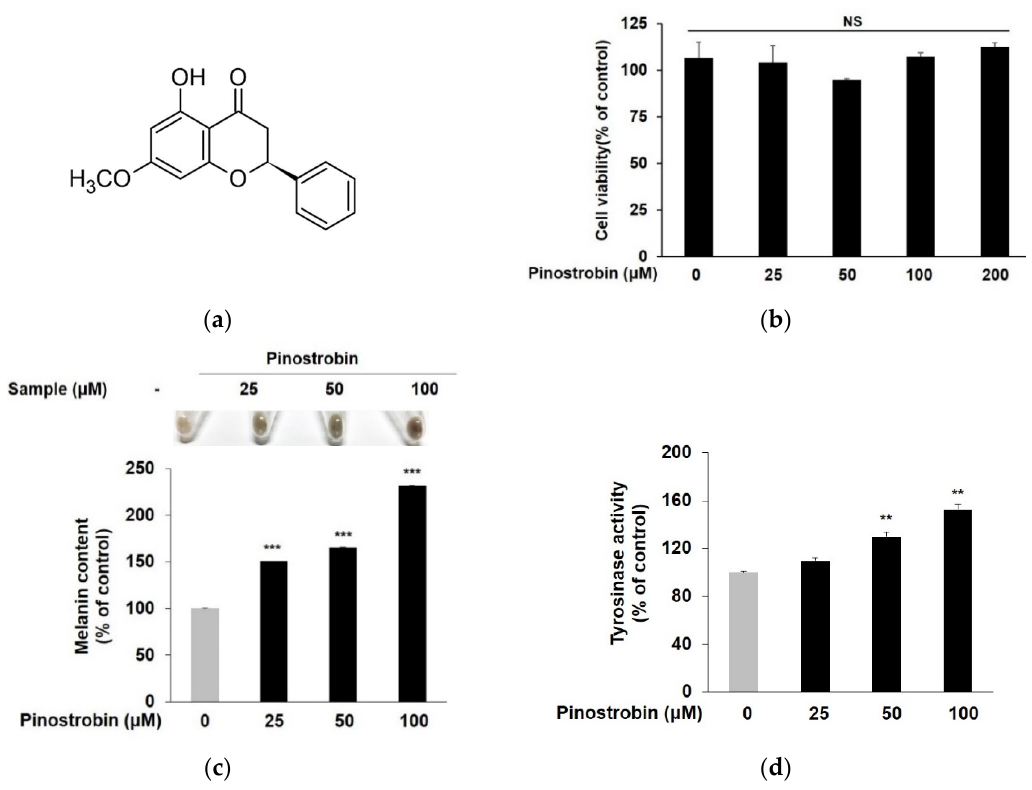
Figure 1. Effect of pinostrobin on cell viability, intracellular melanin contents, tyrosinase activity in B16F10 cells. ( a ) Chemical structure of pinostrobin. ( b ) After treatment with various concentrations of pinostrobin for 72 h, the MTT assay was performed to analyze the cell viability. ( c , d ) After treatment under the same conditions used for the determination of cell viability, cells were collected and lysed to measure intracellular melanin content and tyrosinase activity. Cell viability, intracellular melanin contents, and tyrosinase activity in control cells were regarded as 100%. *** p < 0.001 and ** p < 0.01 compared with control group. NS; not